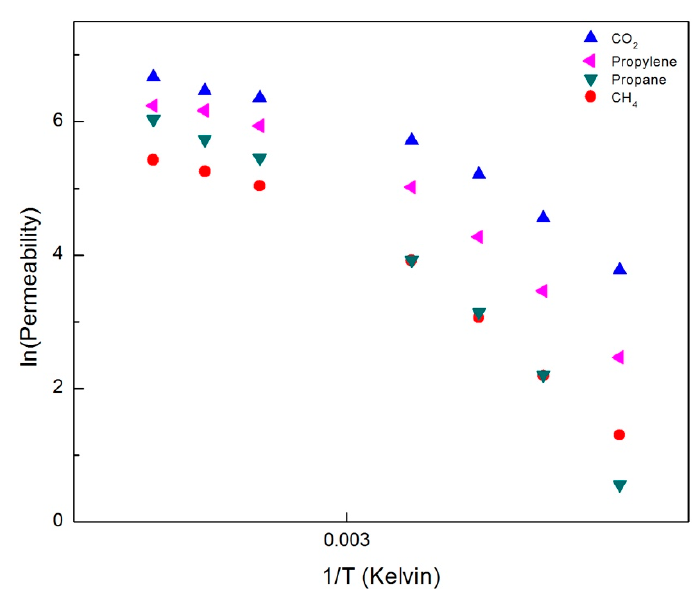
Figure 14. Solubilities for gases in the CNBPh75_5.0 membrane (5.0% crosslinker) in the nematic and isotropic phases.